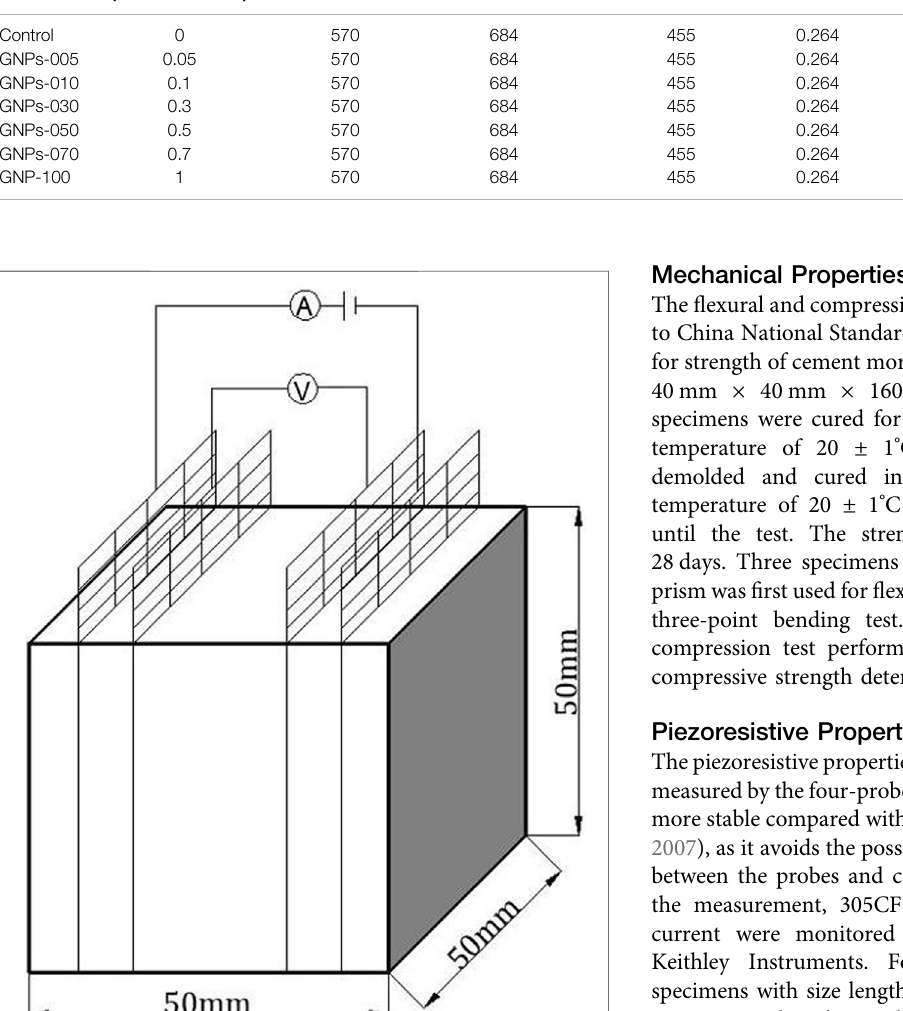
Frontiers in Built Environment |